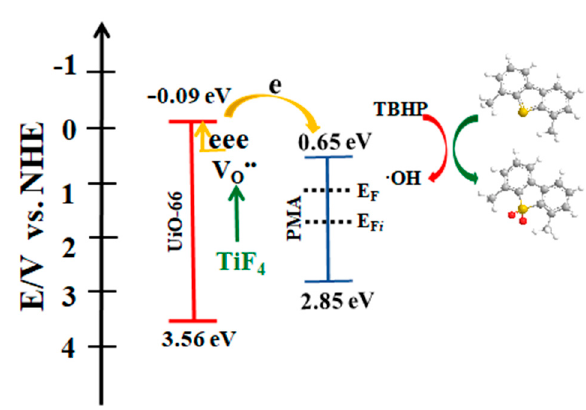
Supplementary Materials: Figure S1: TG curves in an N 2 atmosphere for TiF 4 -PU precursor; Figure S2: BET results of TiF 4 -PU composites obtained at different calcination temperatures (100, 200, 300, 400, 500 ° C); Figure S3: SEM images; Figure S4: XPS spectra of Mo3d; Figure S5: XPS spectra of O 1s ; Table S1: ICP results of PU and TiF 4 -PU catalysts.